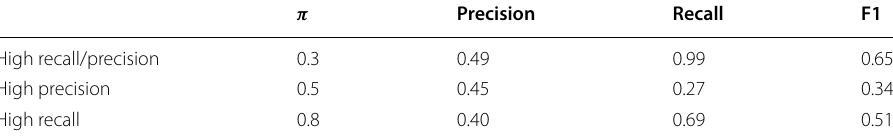
Table 5 The confusion matrix for the network of POLBLOGS with injected edges (Experiment 1) π Precision Recall F1 High recall/precision 0.3 0.49 0.99 0.65 High precision 0.5 0.45 0.27 0.34 High recall 0.8 0.40 0.69 0.51 We show how our model performs in terms of identifying anomalies—edges that have been injected in the dataset—as we vary the anomaly parameters, π . Here µ = 0.5 and ρ a = 0.33